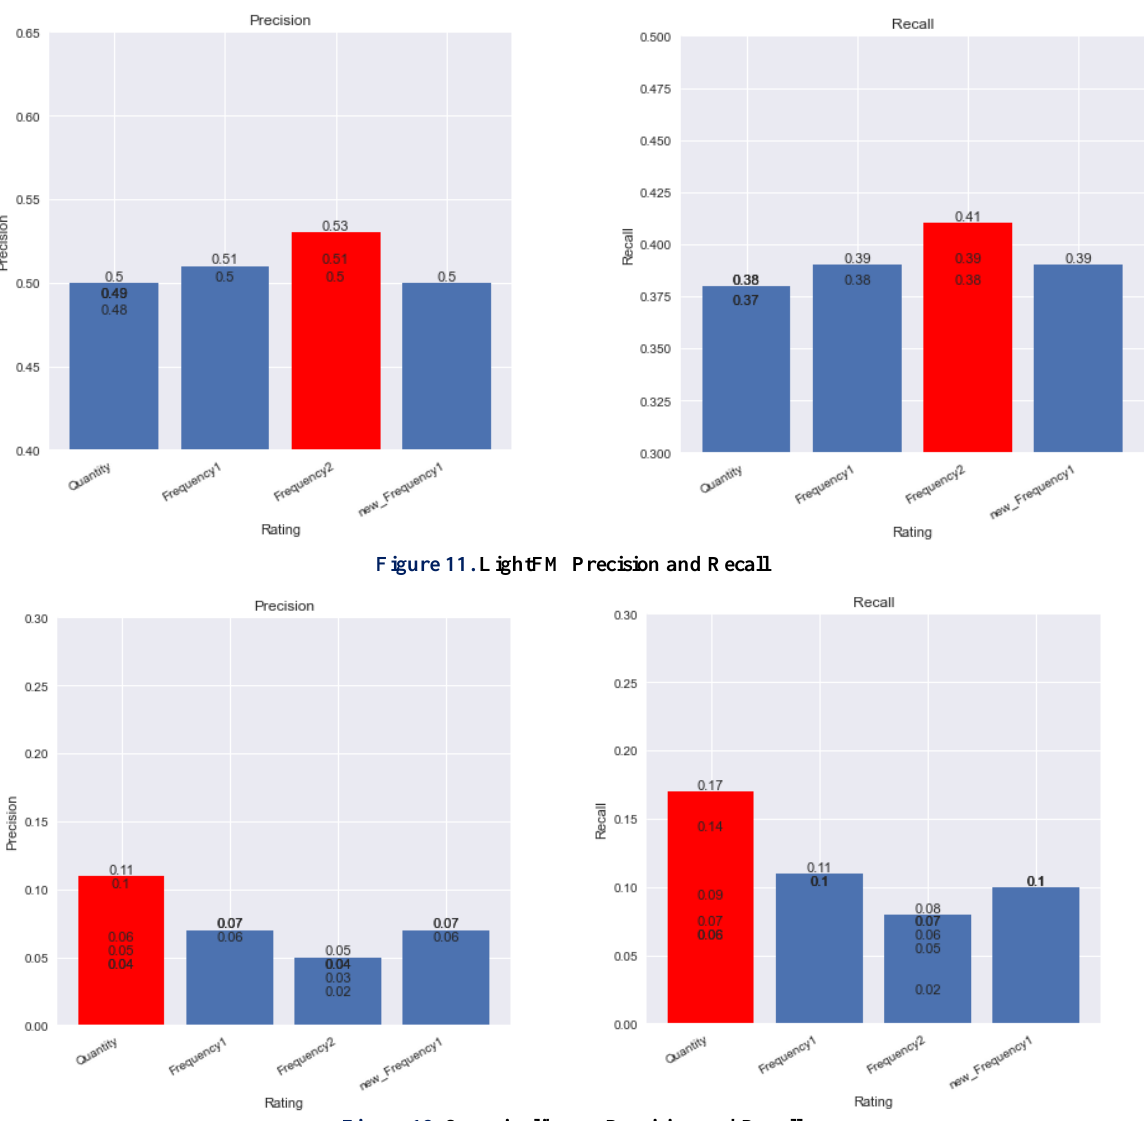
Figure 12. Surprise library Precision and